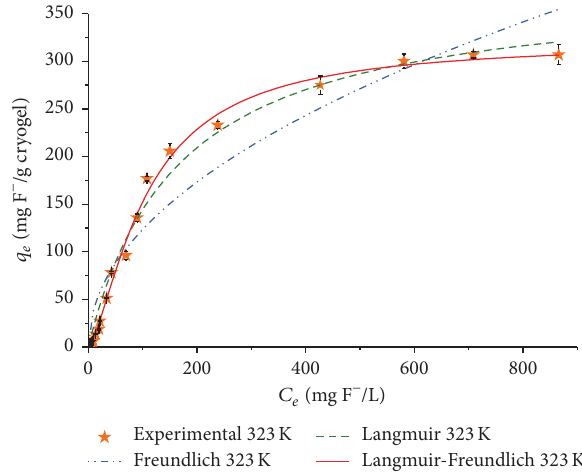
Figure 14: Sorption isotherms, cryogel QE fitted to Freundlich, Langmuir, and Langmuir-Freundlich models; 8 mL, 24 hours of contact, 200 rpm, 0.002 g cryogel mass, pH 6, 𝑇 = 323 K, closed